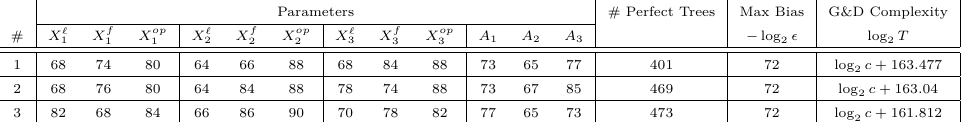
Table 4: List of configurations and associated security parameters. (cid:15) represent maximum linear bias. T is the complexity of guess and determine attack. c represents an additional cost required to do Gaussian elimination to solve a set of linear equations to recover the internal state. Y, Z were set to X op − 3 , X op − 3 and one locations of the 3 and gates to 2 3 X op − 1. A j represents the location of the other tap of the 3 AND gates. The first row j represents the parameters for the original Triad-SC